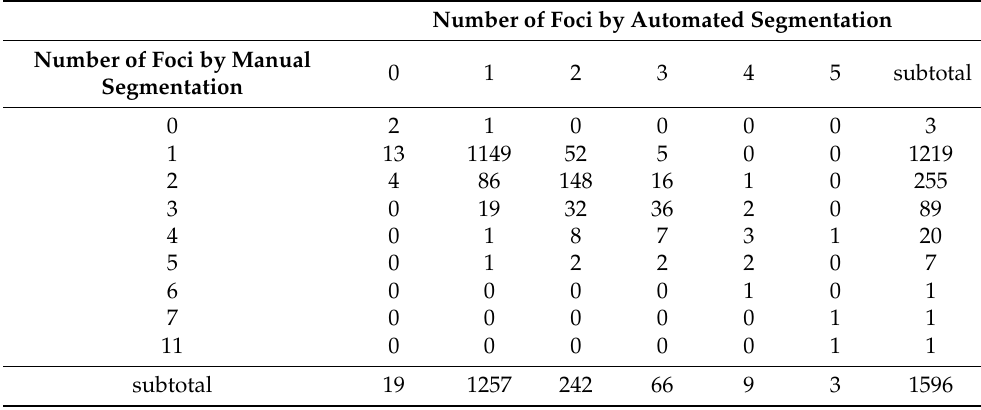
Table 5. Contingency table of multifocality between automated and manual segmentations. Number of Foci by Automated